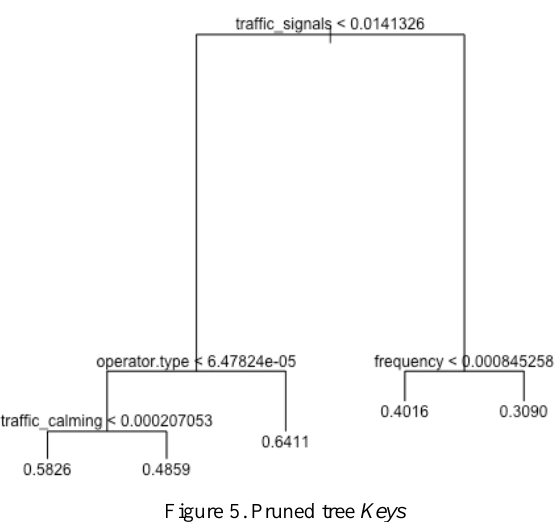
Figure 5. Pruned tree